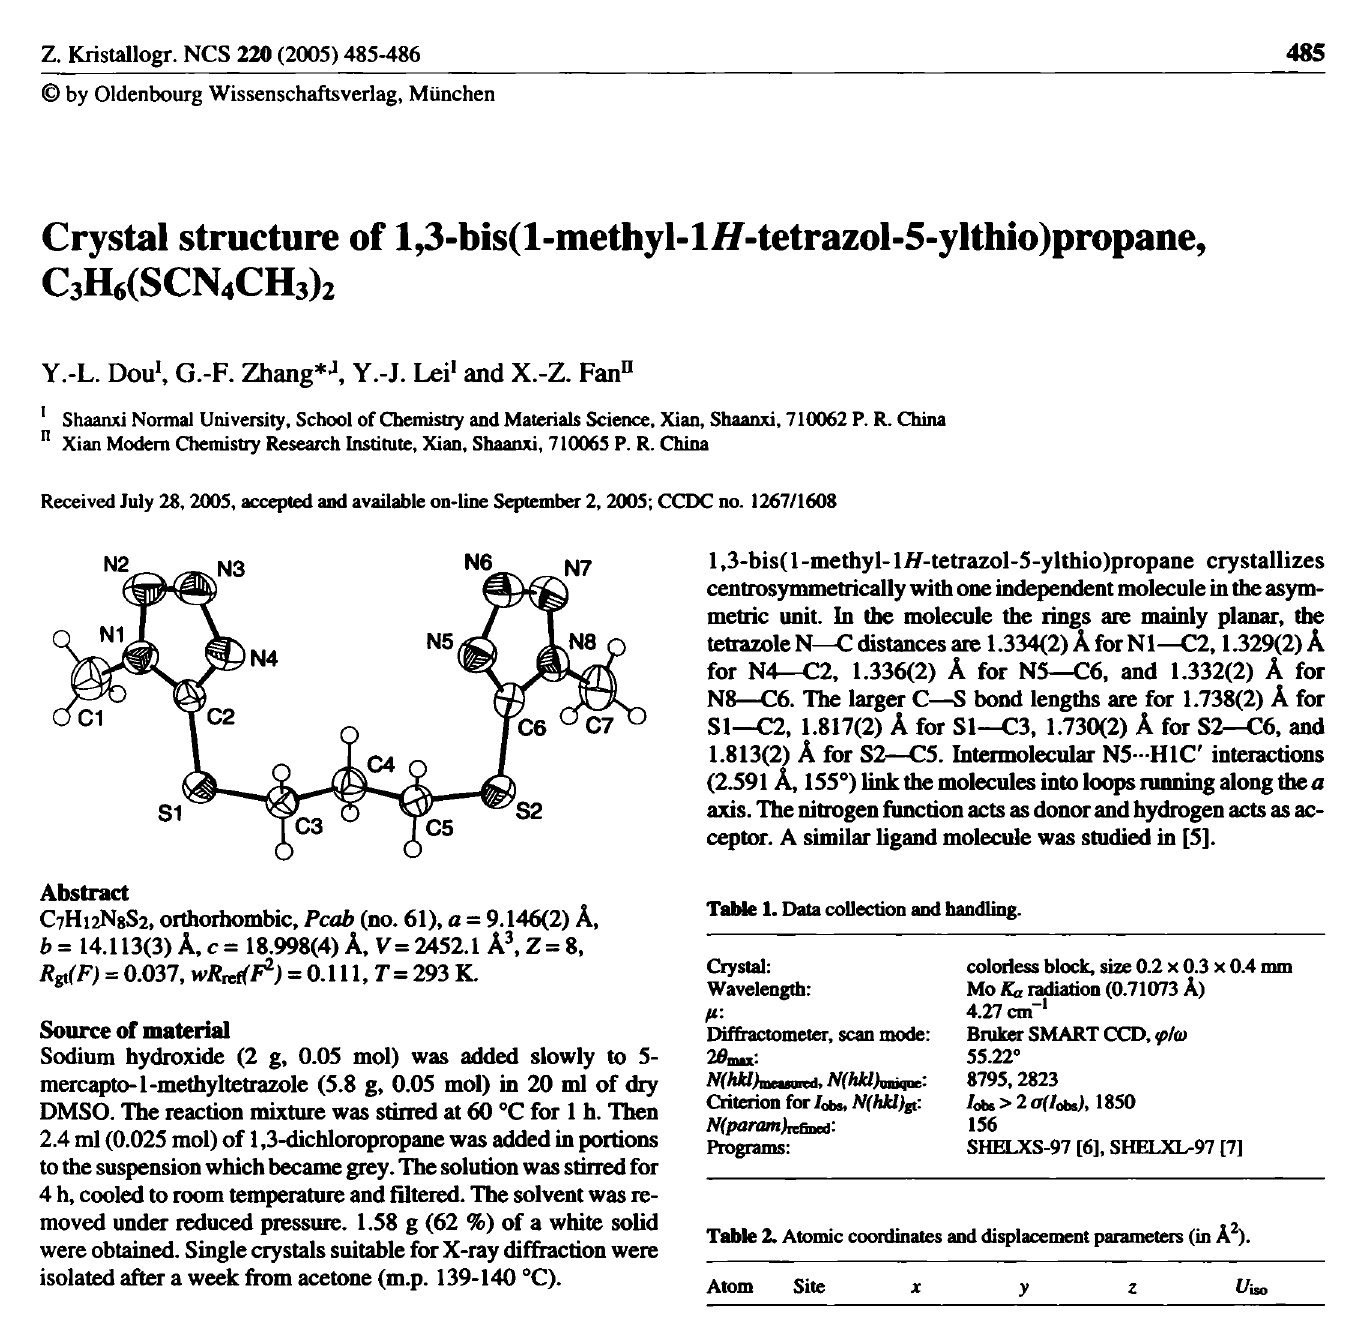
Table 2. Atomic coordinates and displacement parameters (in A 2